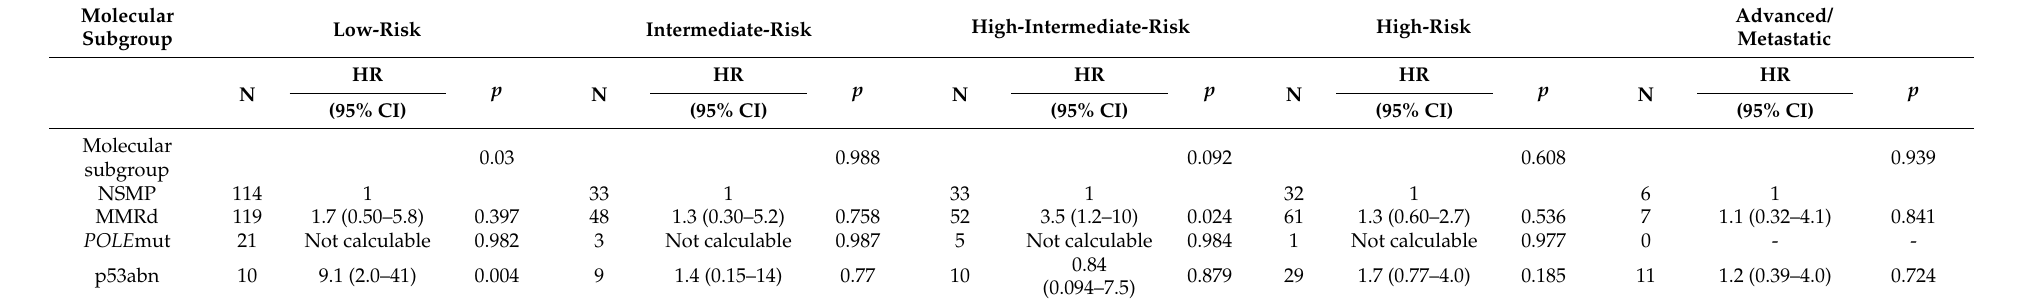
Table 2. Univariable Cox regression disease-specific survival analyses for ESGO/ESTRO/ESP 2021 clinicopathologic risk groups of endometrial carcinoma.